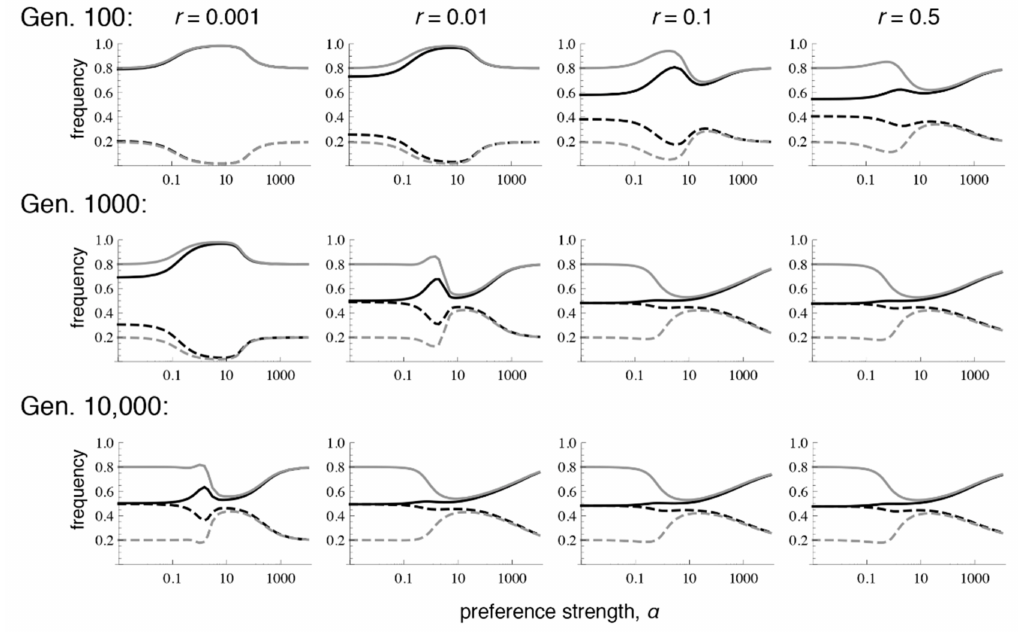
Figure 2. Preference and trait divergence at 100, 1000, and 10,000 generations (Gen) after secondary contact when the trait is expressed in both sexes. The parameter values and legend follow Figure 1. Note that with r = 0.001, equilibrium has not yet been reached at 10,000 generations (at equilibrium, this case will resemble the rest of the